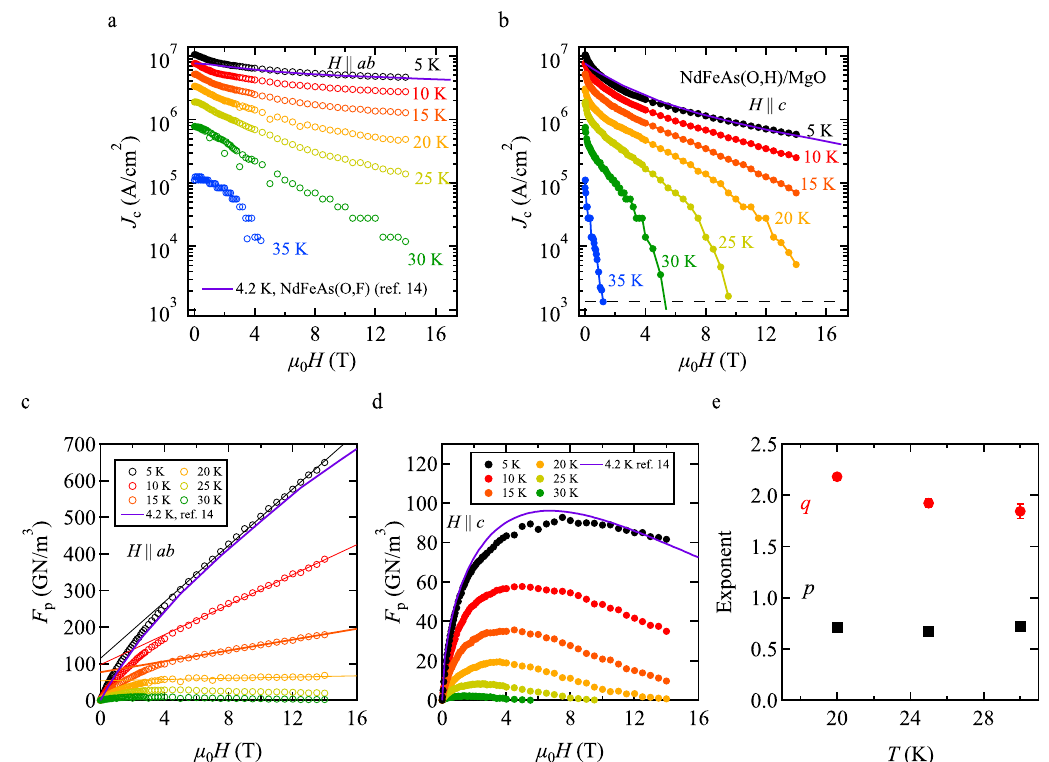
Figure 4. In-field electrical transport J c characteristics and pinning force density F p . Field dependence of J c at various temperatures for ( a ) H || ab and ( b ) H || c . Corresponding pinning force density F p for ( c ) H || ab and ( d ) H || c . For comparison, the data of NdFeAs(O,F) measured at 4.2 K are superimposed 14 . ( e ) Temperature dependence of exponents p and q in f p ~ h p (1 − h ) q for H || c